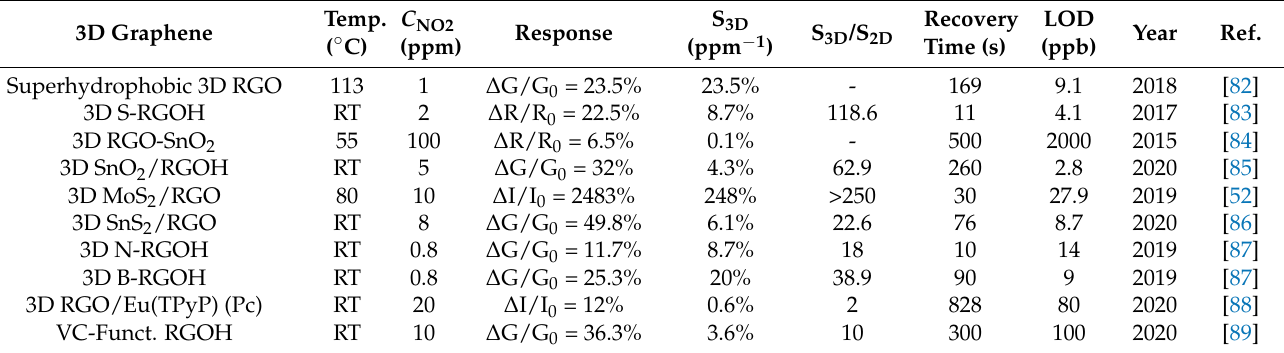
Table 1. Gas sensitivities of 3D graphene toward NO